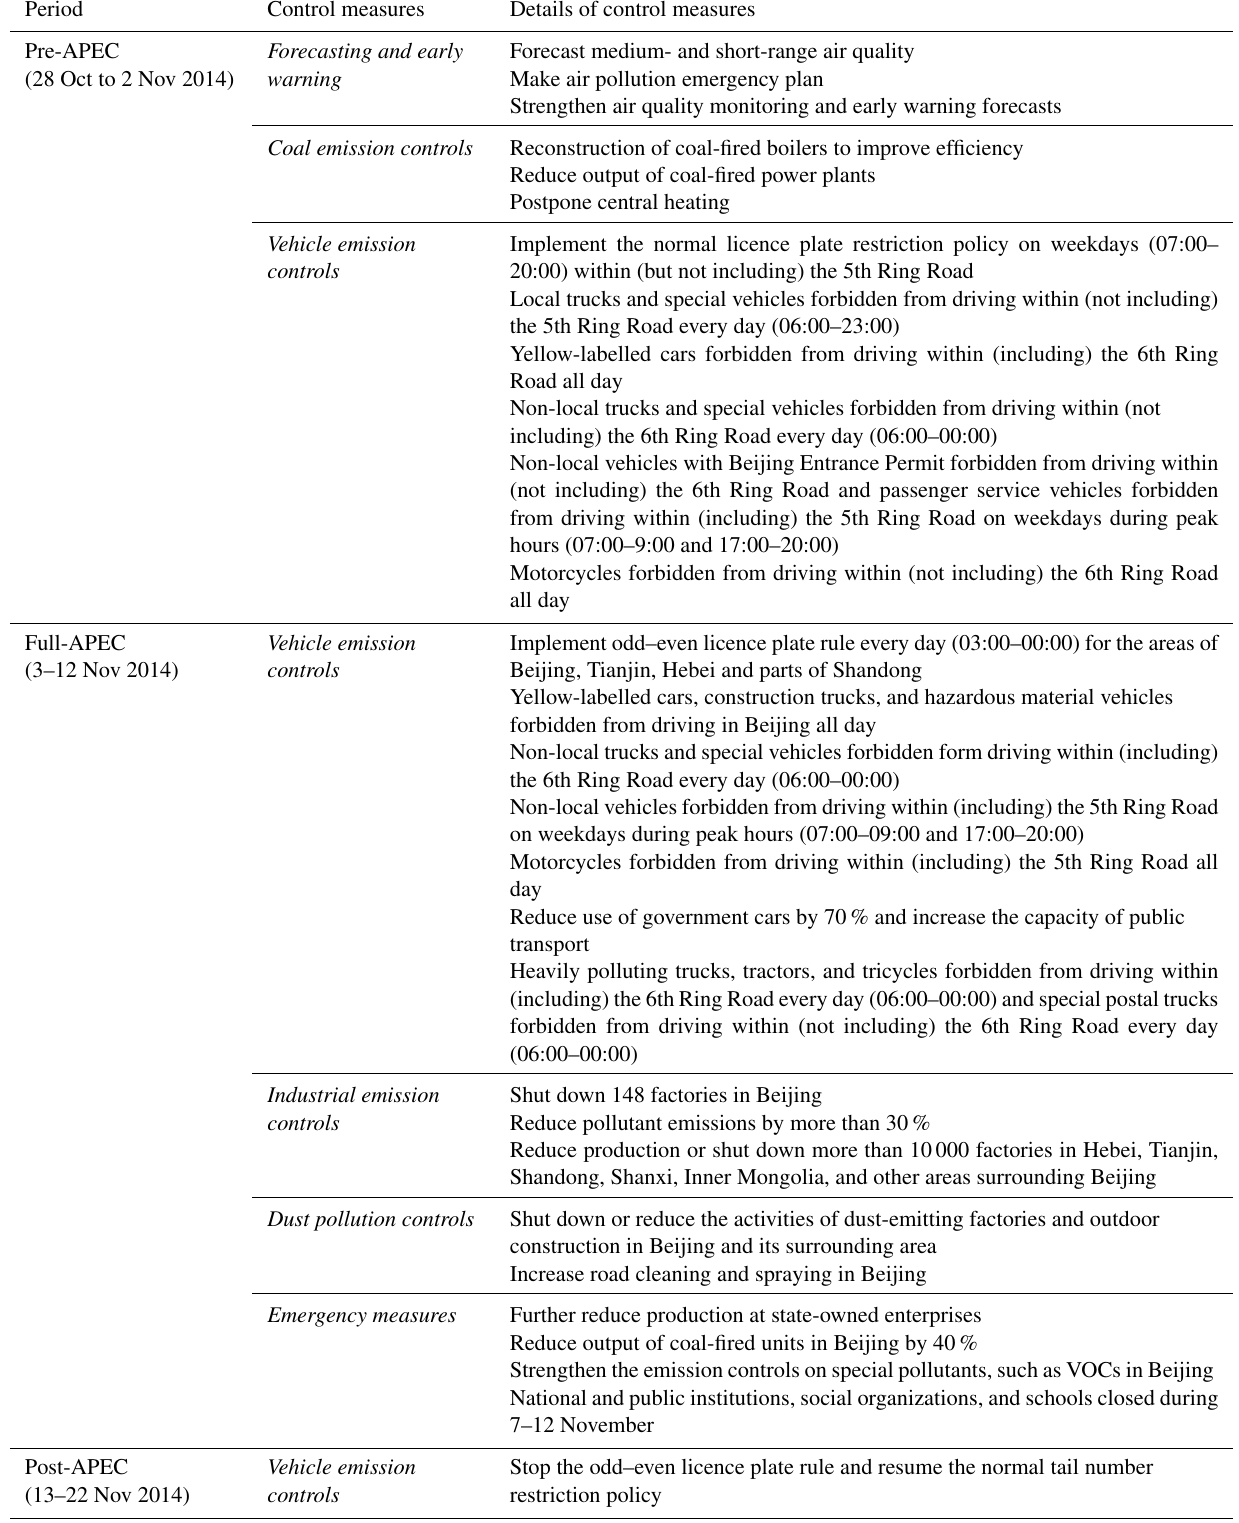
Table 1. Air pollution control measures implemented during the pre-APEC, full-APEC, and post-APEC periods.